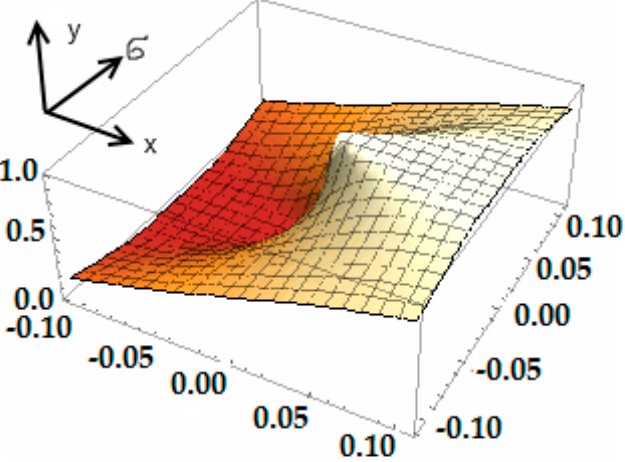
Figure 9. 3D image of a Gaussian distribution density of a normalized random variable y = θ ( u ) , where x = u = (e i − ξ )/( ξ · σ ), with center ξ and dispersion σ 2